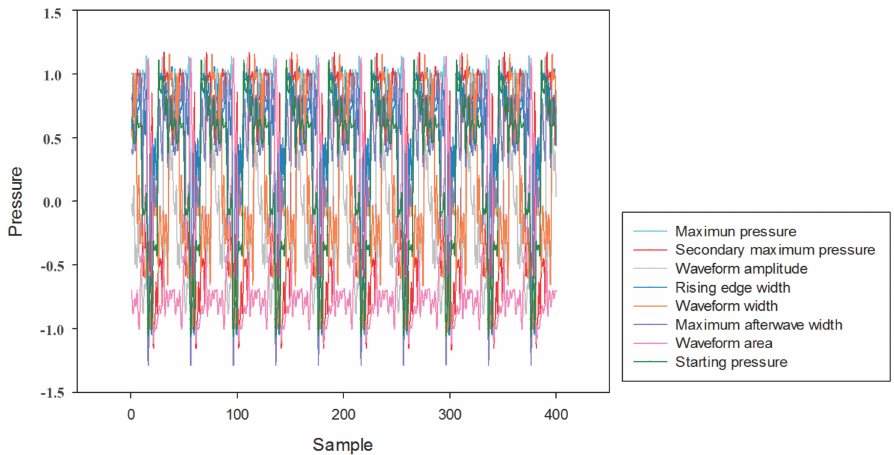
Figure 8. Pressure wave characteristics of training